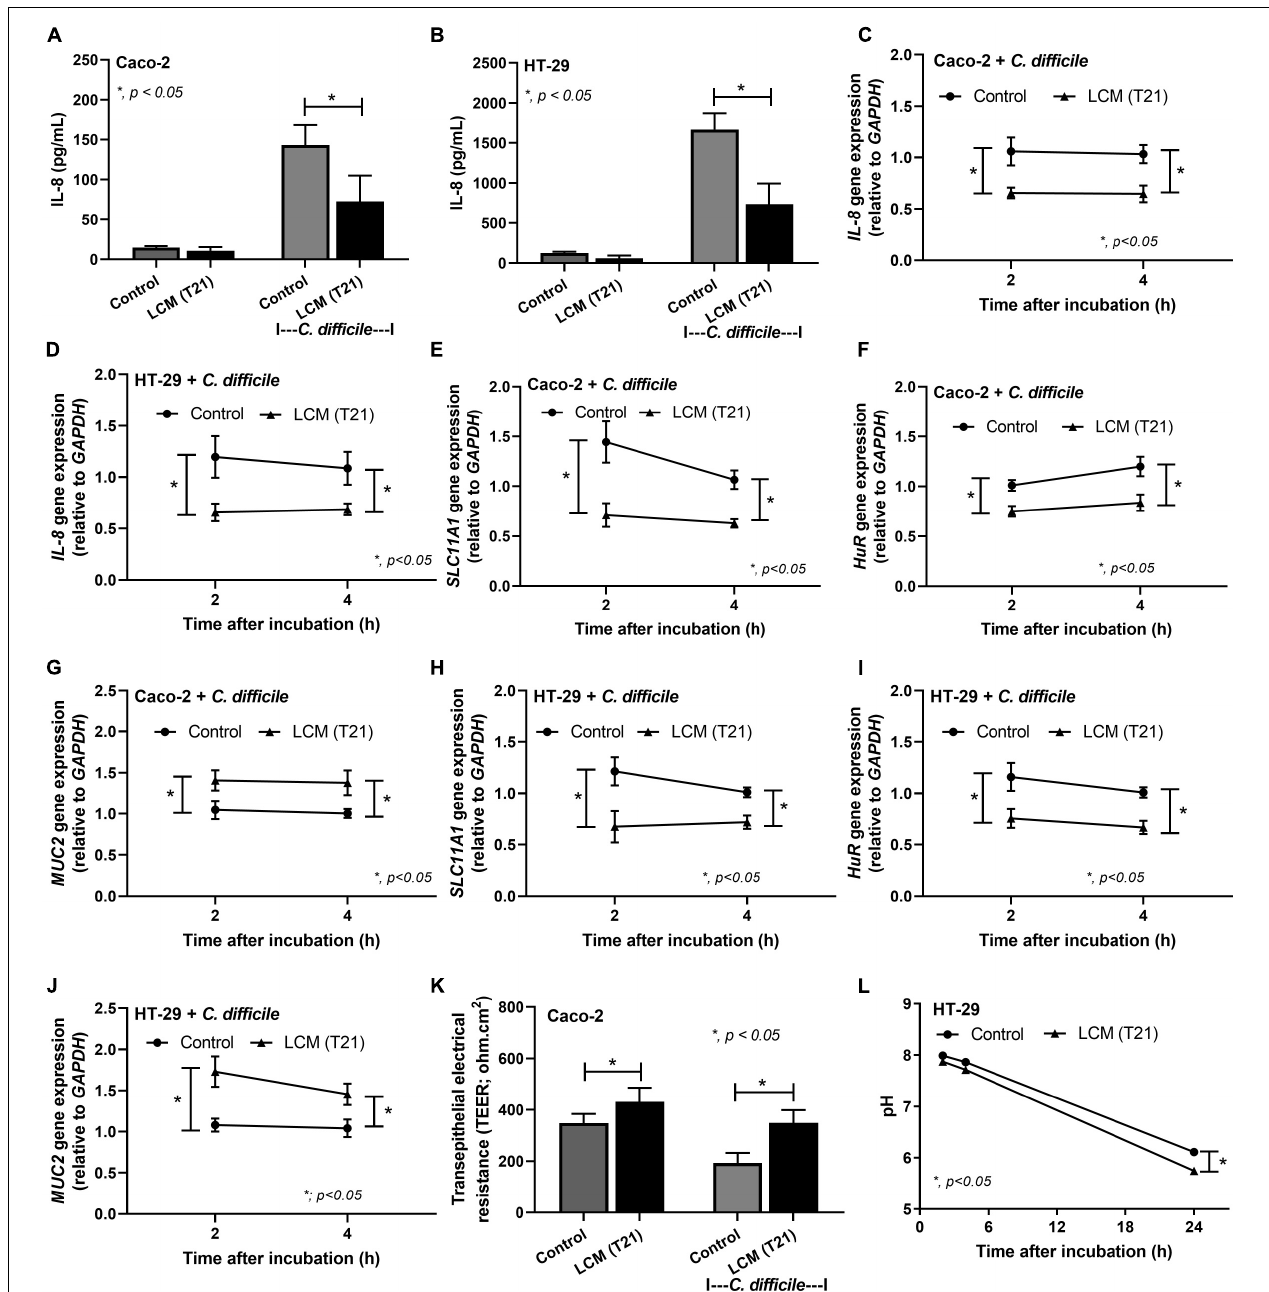
FIGURE 6 | The Lacticaseibacillus casei -conditioned medium (LCM) of L. casei T21 attenuated C. difficile -induced IL-8 production, host gene expression, and increased transepithelial electrical resistance of C. difficile -stimulated colonic epithelial cells. The results are shown as IL-8 production in Caco-2 and HT-29 cells, respectively (A,B) ; IL-8 gene expression (relative to GAPDH ) in Caco-2 and HT-29 cells, respectively (C,D) ; the expression of SLC11A1 , HuR , and MUC-2 in Caco-2 cells, respectively (E–G) ; the expression of SLC11A1 , HuR , and MUC-2 in HT-29 cells, respectively (H–J) ; the transepithelial electrical resistance (TEER) values of Caco-2 cells (K) ; and the pH of cell culture medium (McCoy’s 5A modified medium for HT-29 cells) (L) . The results were from three independent experiments each in triplicate and expressed as the mean ± SEM. *p <